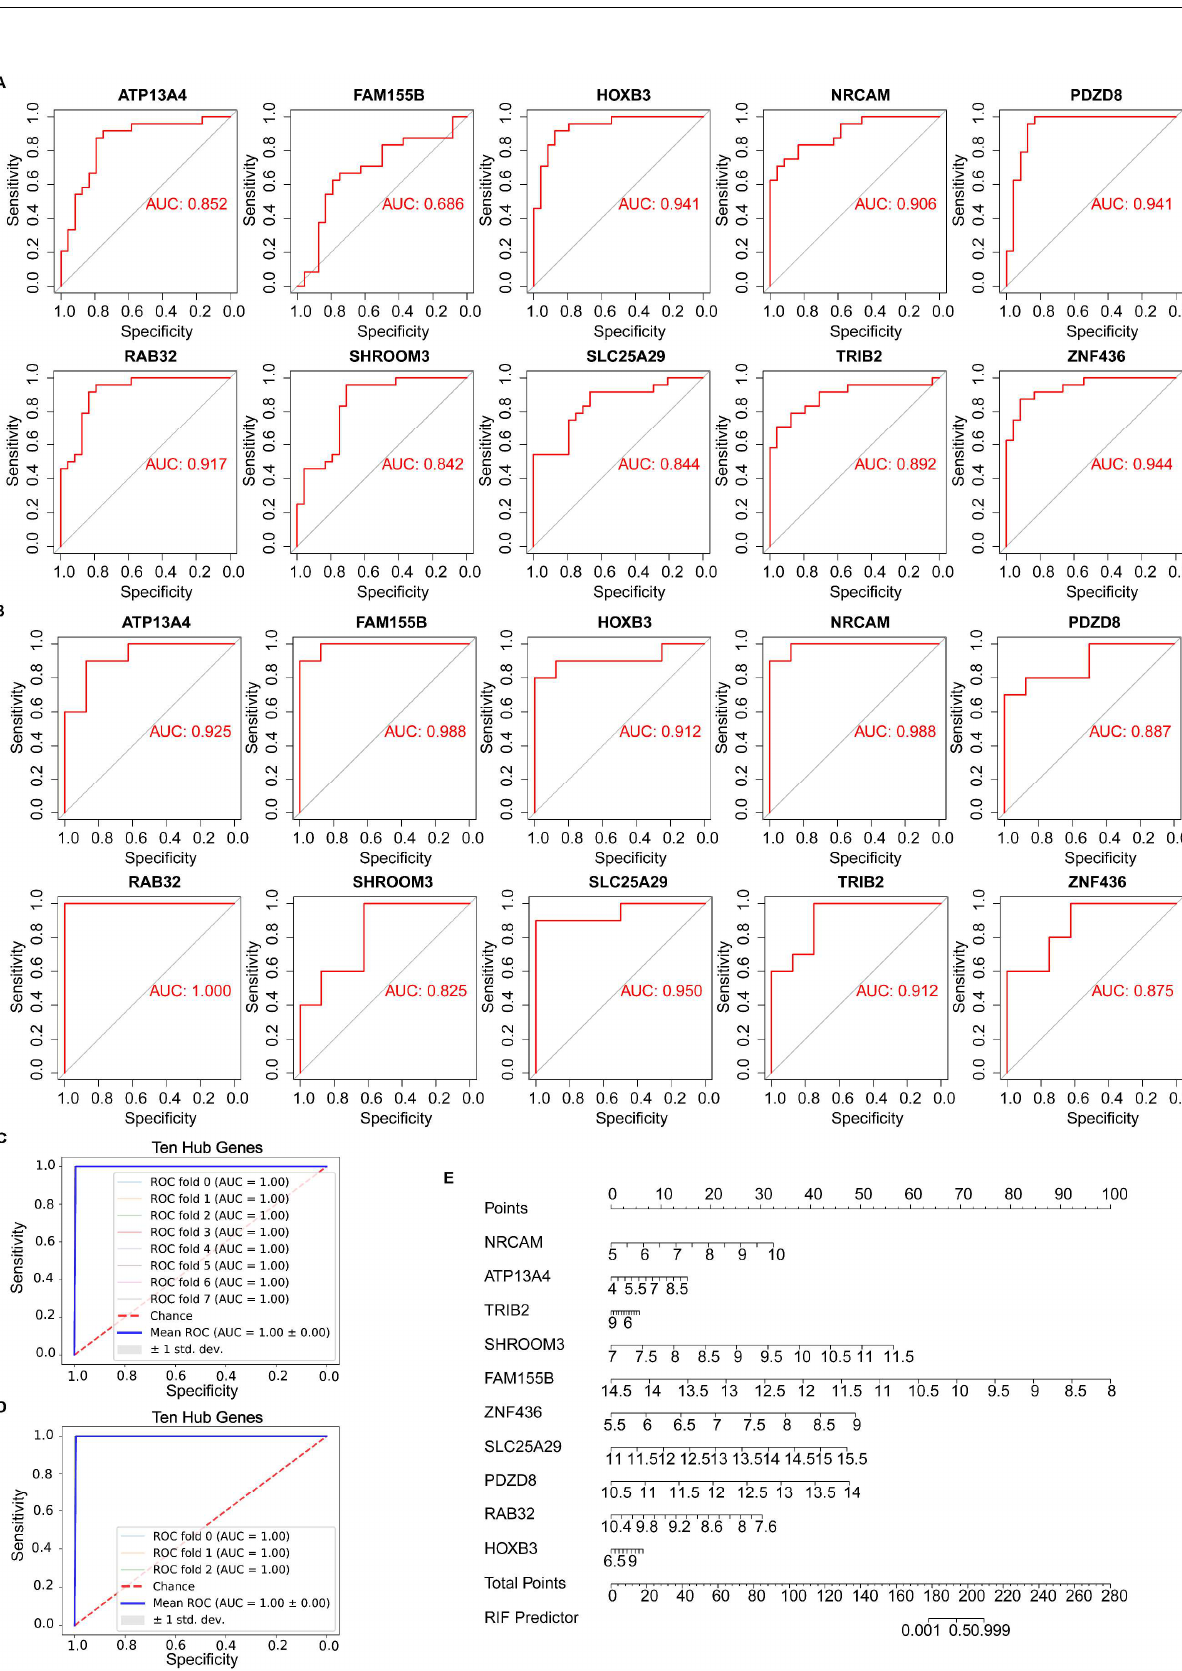
Figure 6. Validation of the hub gene diagnostic value. Every hub gene in the ( A ) GSE111974 and ( B ) GSE92324 datasets. Combined validation of the ten hub genes in the ( C ) GSE111974 and ( D ) GSE92324 datasets. ( E ) Diagnostic nomogram for the ten hub genes in the GSE111974